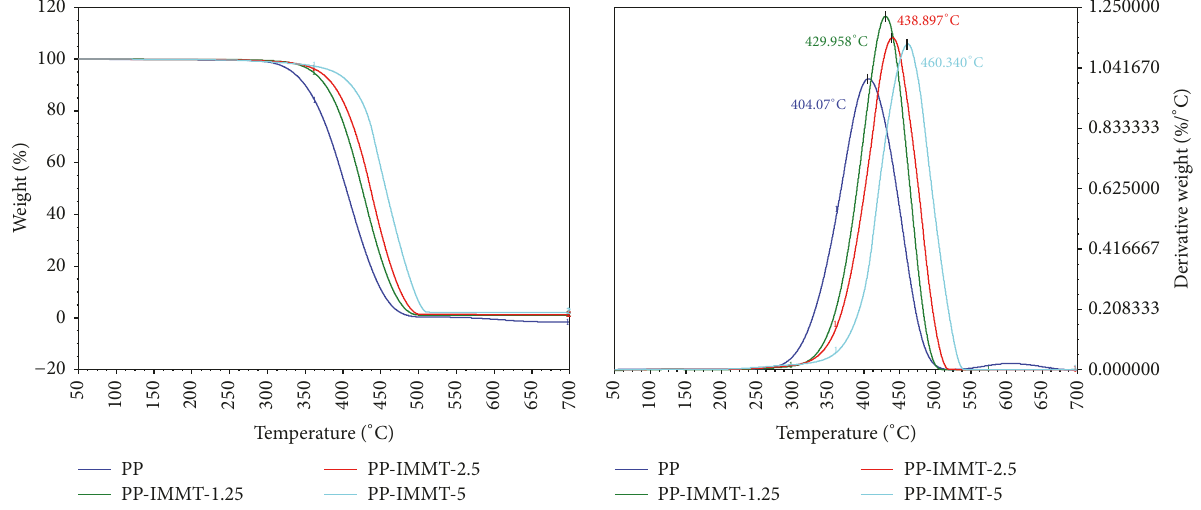
Figure 5: TGA trace and derivative curves of PP-IMMT